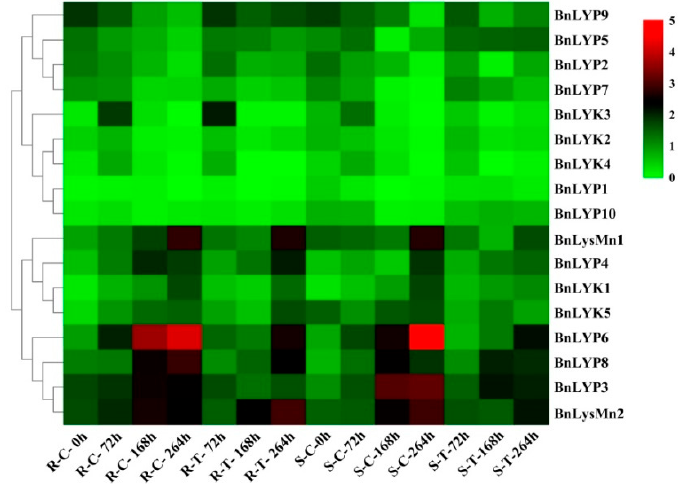
Figure 7. The expression pattern of LysM-RLK genes in response to Leptosphaeria maculans infection. The color boxes indicate expression values, the lowest (green), medium (black), and the highest (red). R, S, C, and T indicate resistant (DF78), susceptible (Westar), control, and treatment plants, respectively.